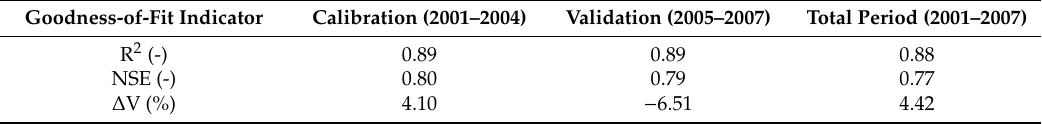
Table 4. Numerical comparison between simulated and measured total runo ff